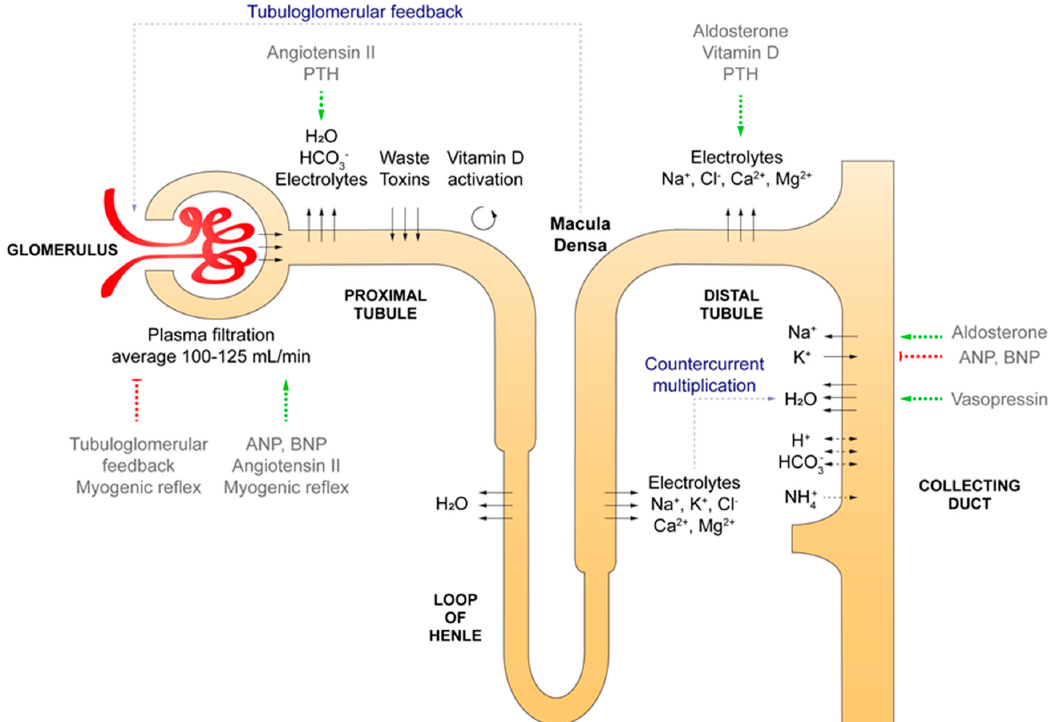
Figure 1. Summary of the main filtration, reabsorption, excretion and endocrine processes across the nephron. Important hormones and mechanisms that regulate these functions are depicted in grey.